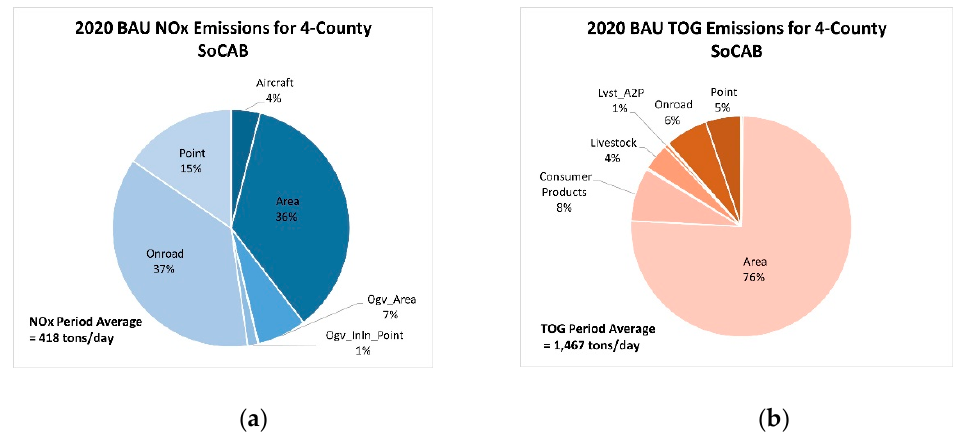
Figure 2. Four-county South Coast Air Basin 2020 BAU emissions by sector: ( a ) NOx emissions; ( b ) TOG emissions.